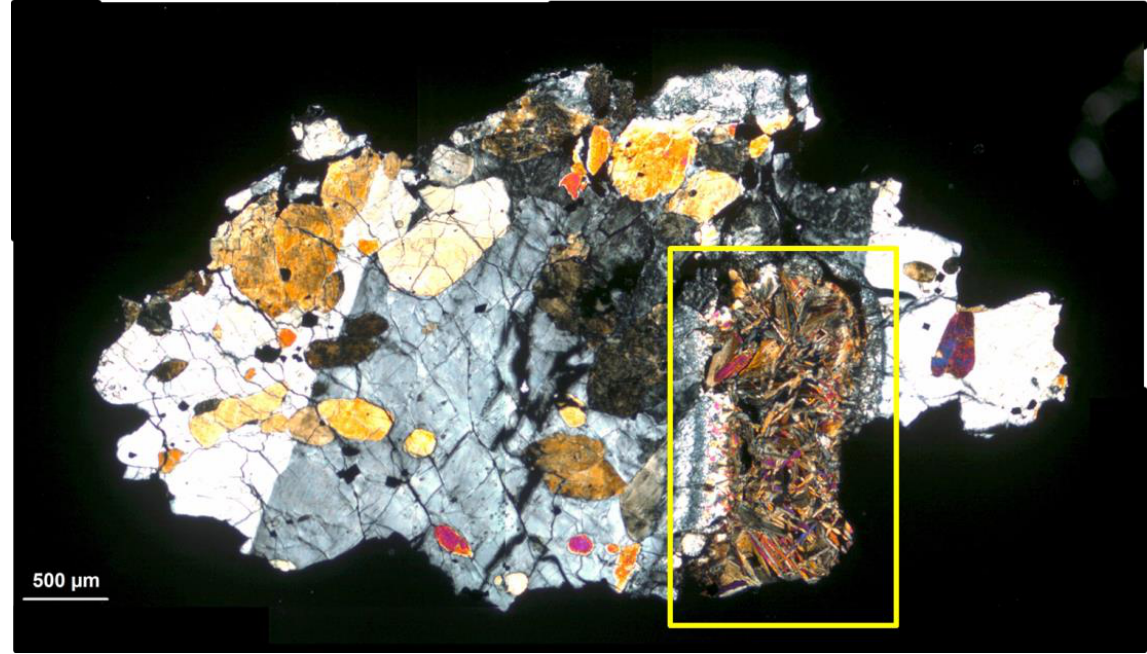
Figure 4. ALH-77005 thin section with crossed polars: poikilitic texture of olivine with pyroxene cumulate grains, the studied melt pocket (rectangle) mostly composed of olivine.